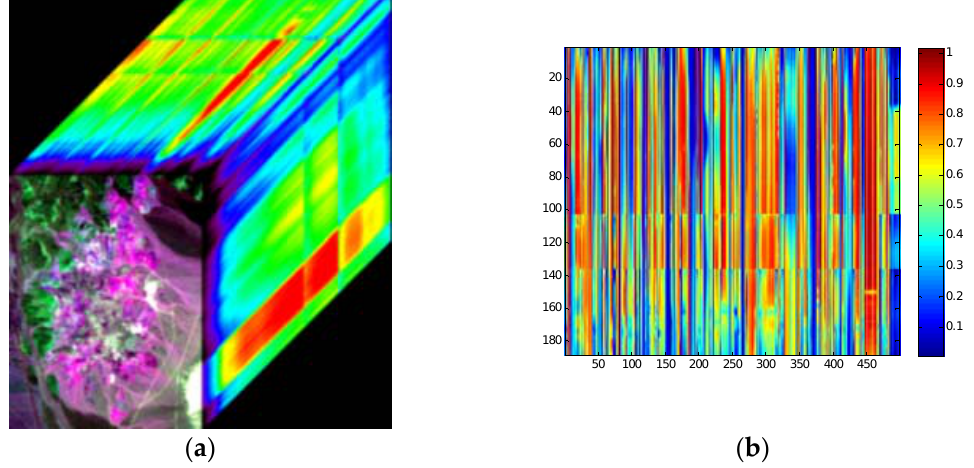
Figure 5. Cuprite dataset . ( a ) Cuprite data; ( b ) United States Geological Survey (USGS) mineral spectral library.